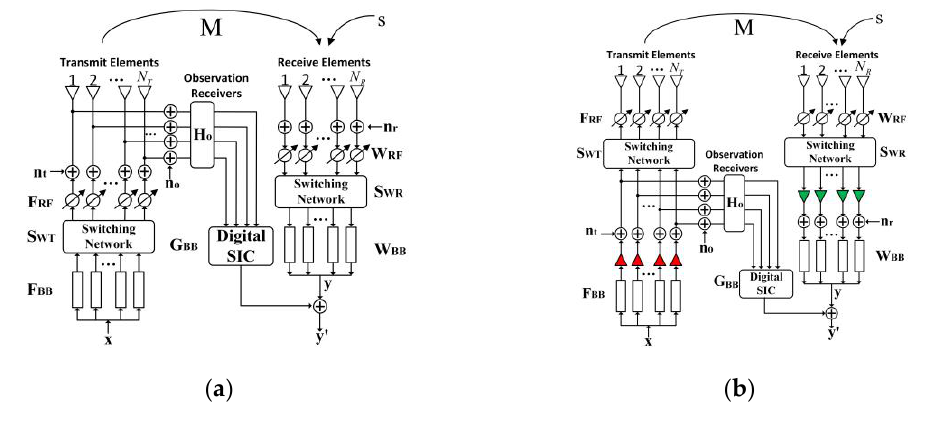
Figure 4. ( a ) HBF-SN-ALSTAR-AO; ( b ) HBF-SN-ALSTAR-RFO.